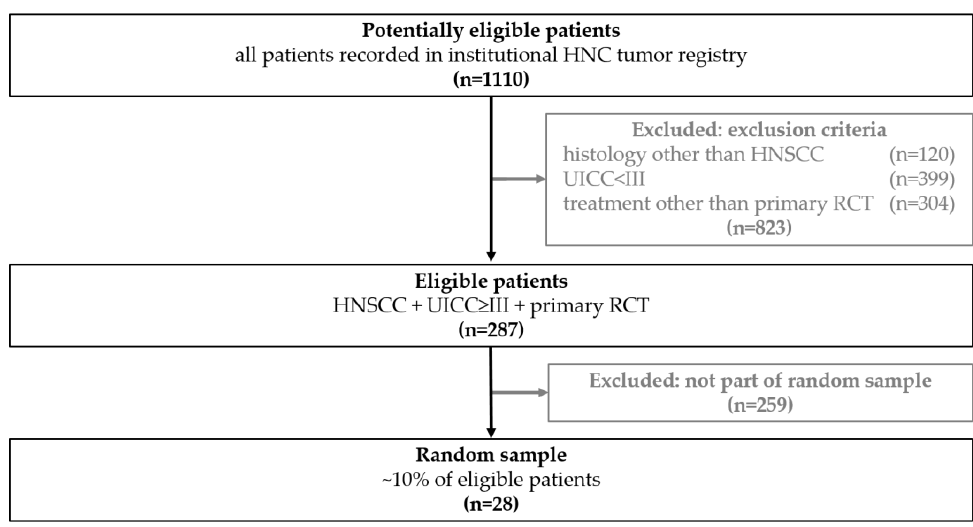
Figure 1. Study flow and patient inclusion modified according to STARD criteria [19]. A total of 1110 patients were potentially eligible, of which 823 did not meet the inclusion criteria. Of 287 eligible patients a representative random sample of 28 patients (~10%) was drawn. The clinical characteristics of the 28 included patients are presented in Table 1.